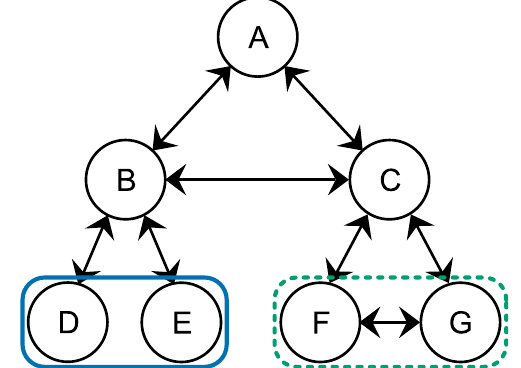
FIG. 1. A sample work network, where ties mean “ meets weekly with. ” Positional analysis can identify layers of this example hierarchy, but structural equivalence will produce a more restrictive grouping than regular equivalence. By exact structural equivalence, only D/E (solid blue line) and F/G (dashed green line) are grouped together, with all other actors occupying single- member